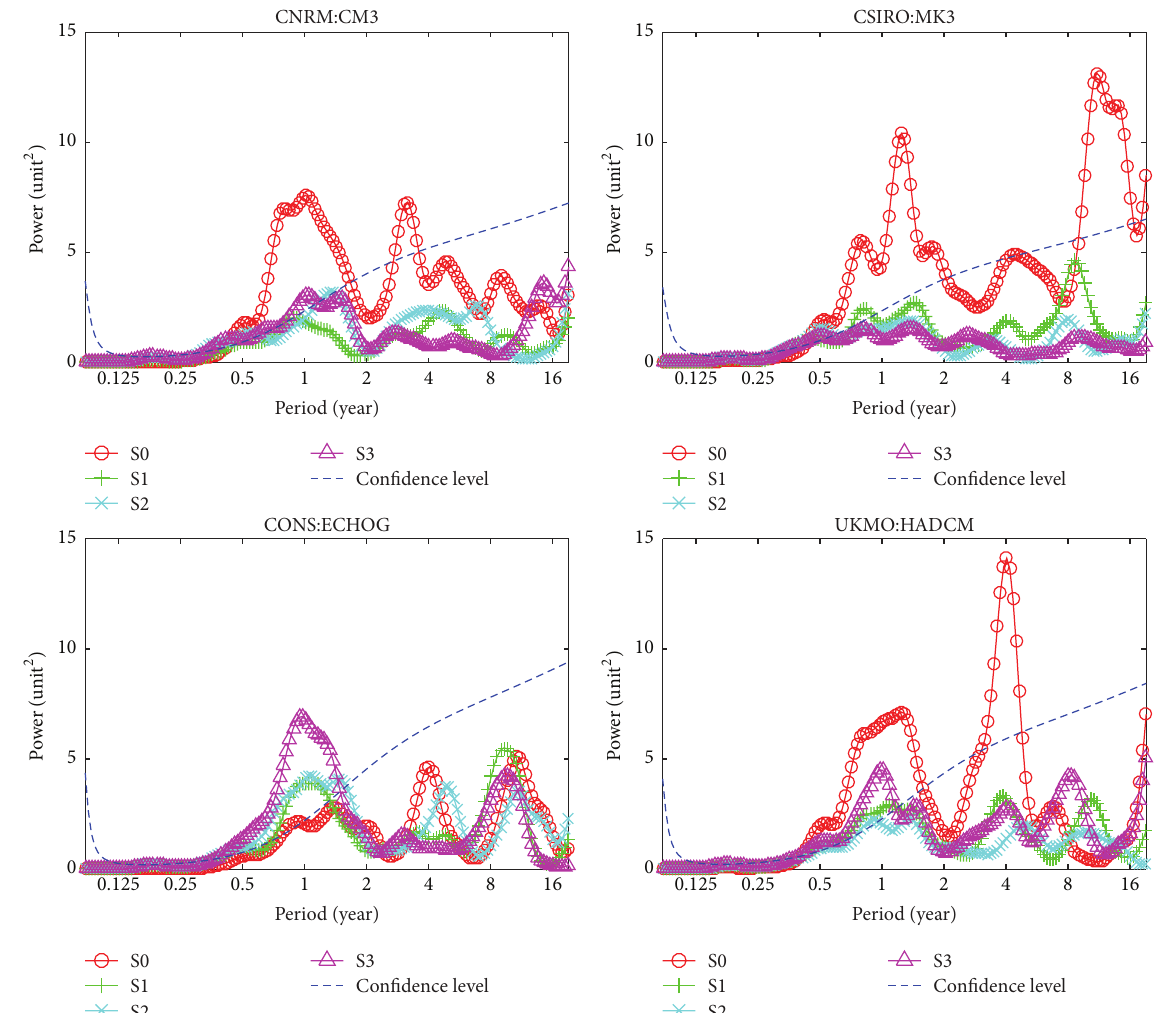
Figure 5: A comparison of global wavelet spectra for the Han River watershed (S0: 1976 ∼ 2010, S1: 2011–2040, S2: 2041–2070, and S3: 2071– 2099). The dashed blue line is the significance for the global wavelet spectrum, assuming the same significance level and background spectrum as in wavelet power spectra. All analyses employed the Morlet